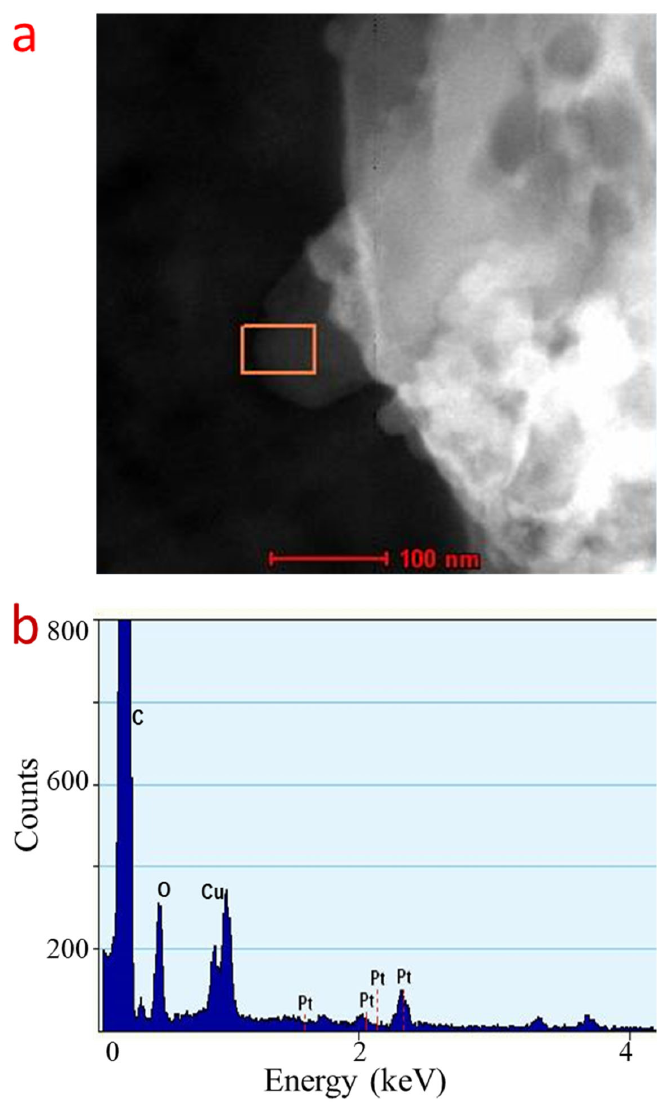
Figure 3. Elemental analysis of 2D crystal of Pt. ( a ), Electron image of the 2D crystal of Pt. ( b ), EDS elemental spectroscopy at the position shown as box in ( a ).